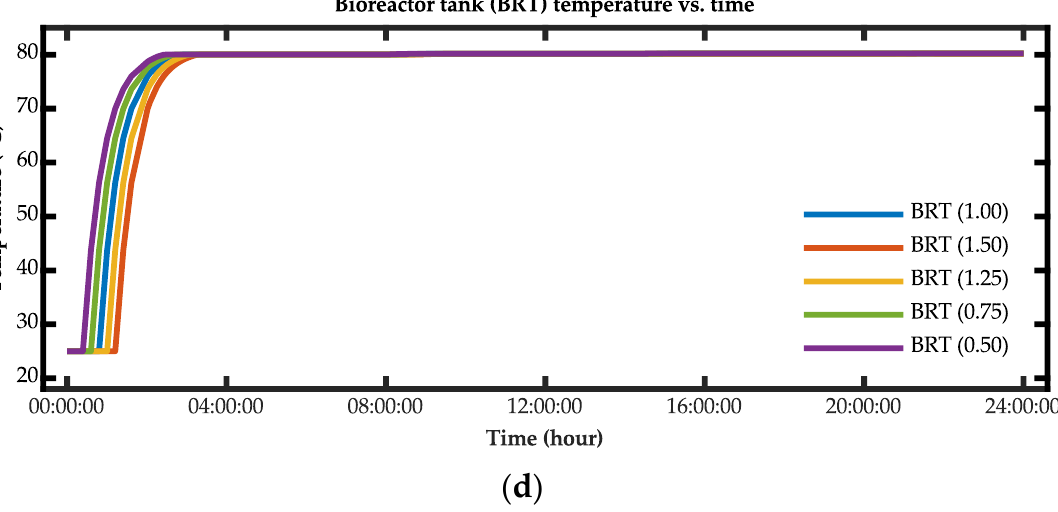
Table 9. Bioreactor tank time constants based on the scale factors of the feed-mixing tank.